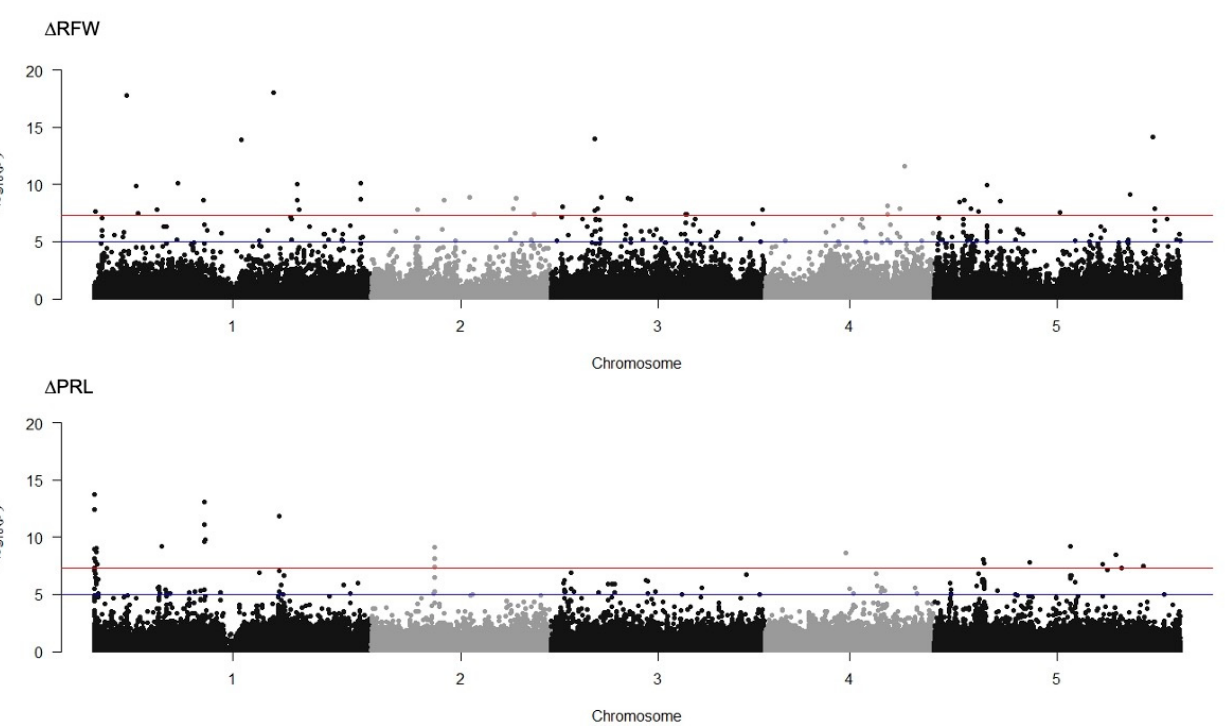
Figure 4. Manhattan plot of GWA mapping of A. olearius DQS-4 T effects on root fresh weight ( ∆ RFW) and primary root length ( ∆ PRL) in − log 10 ( P ). SNP marker trait associations are shown as black and grey dots for each chromosome. The red and blue lines indicate the arbitrary thresholds of − log10( P ) = 5 and − log10( P ) = 7.